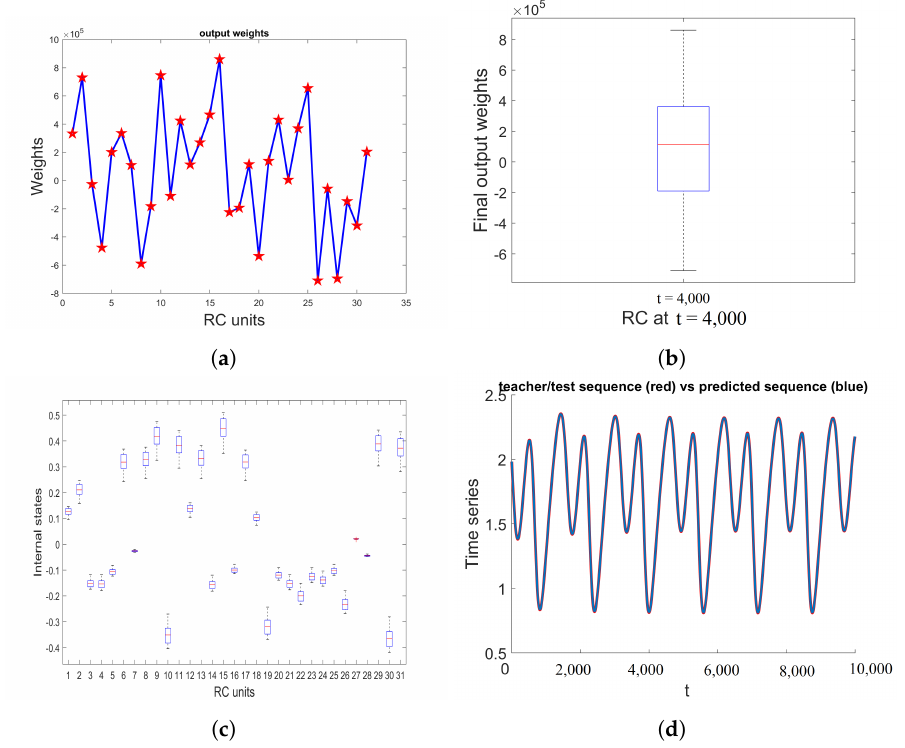
Figure 8. Similar to Figure 4 but for the case where σ =